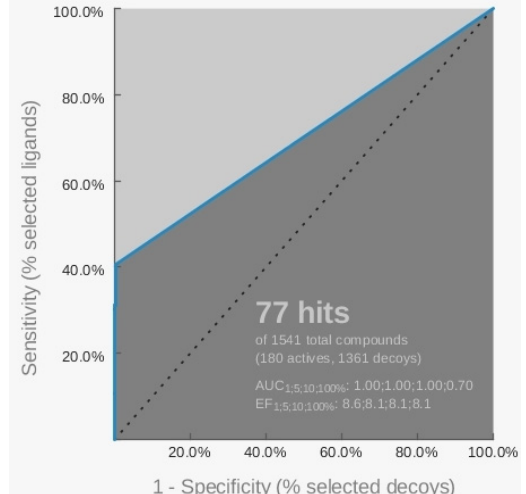
Figure 4. Representation of the ROC curve related to the pharmacophore H_3 generated starting from the 3SC8 PDB model by LigandScout